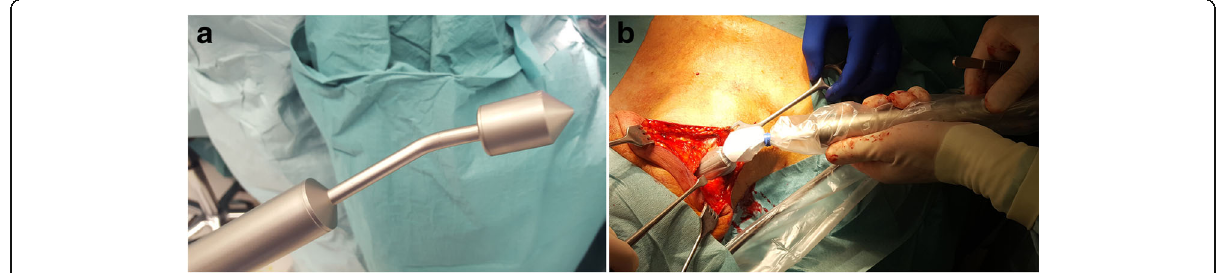
Fig. 1 a High-energy gamma probe. b Intraoperative use of the handheld high-energy gamma probe